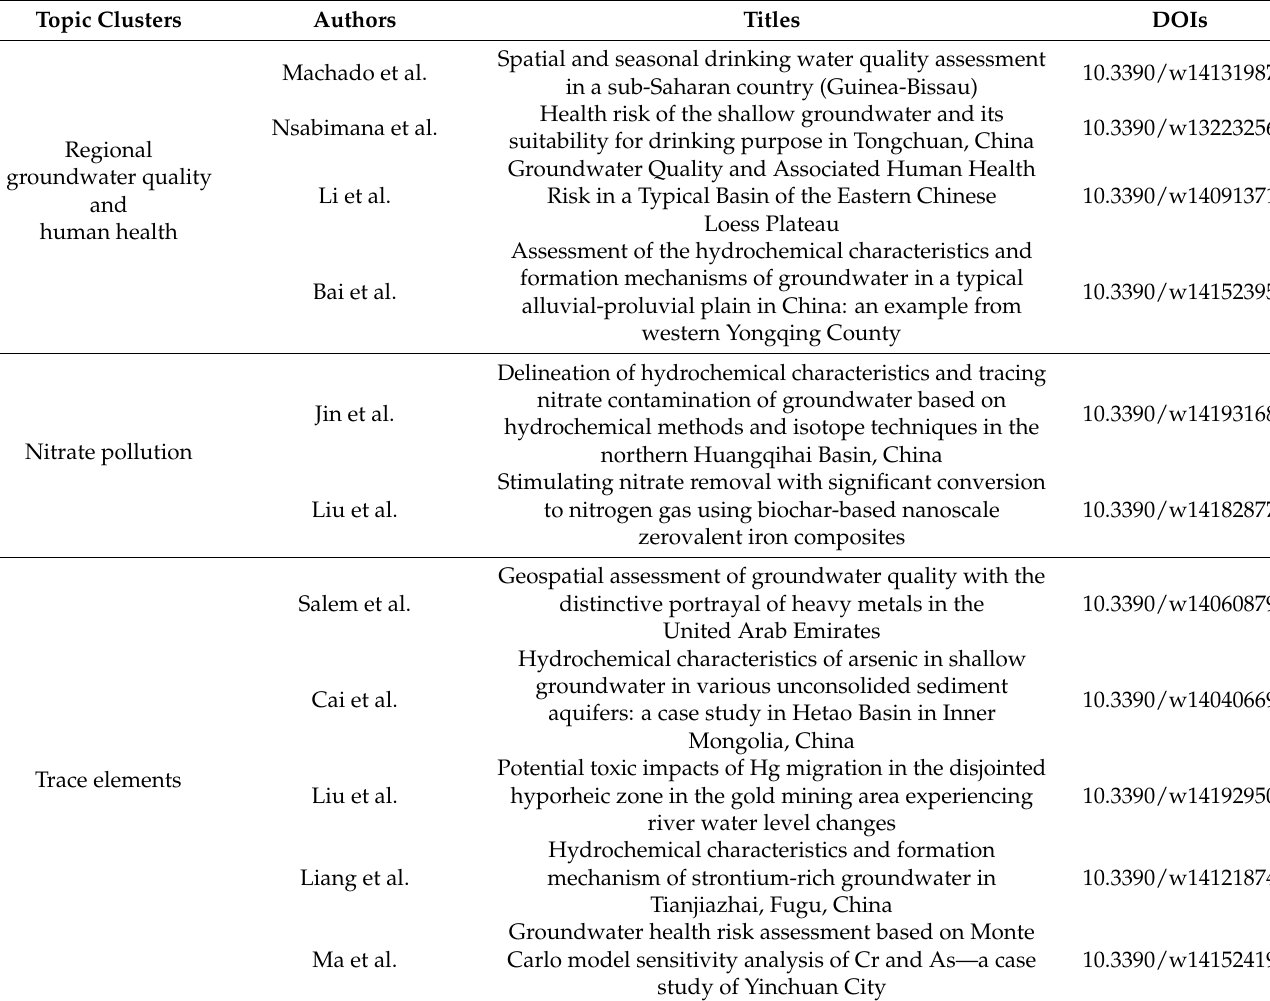
Table 1. Information of research papers in the Special